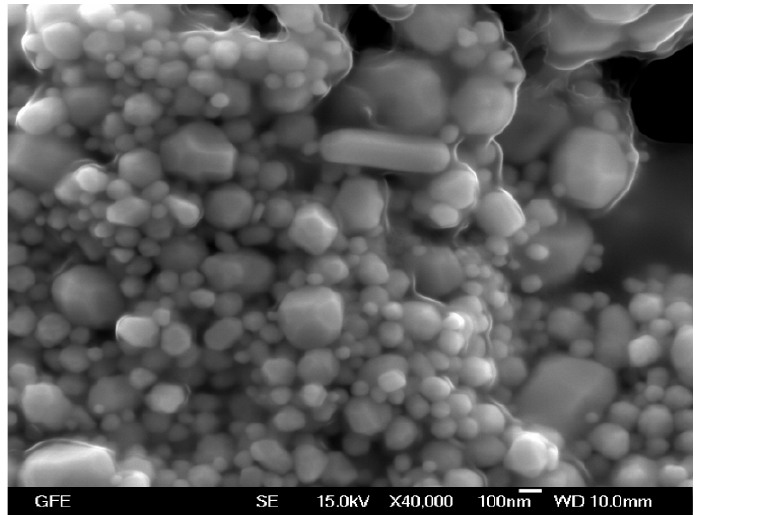
Figure 4 – Gold nanoparticles produced by USP (T=260°C, 2.5 MHz) Рис . 4 – Наночастицы золота , полученные ультразвуковым распылением раствора (T=260°C, 2.5 MHz) Слика 4 – Наночестице злата произведене ултразвучним распршивањем раствора (T=260°C, 2,5